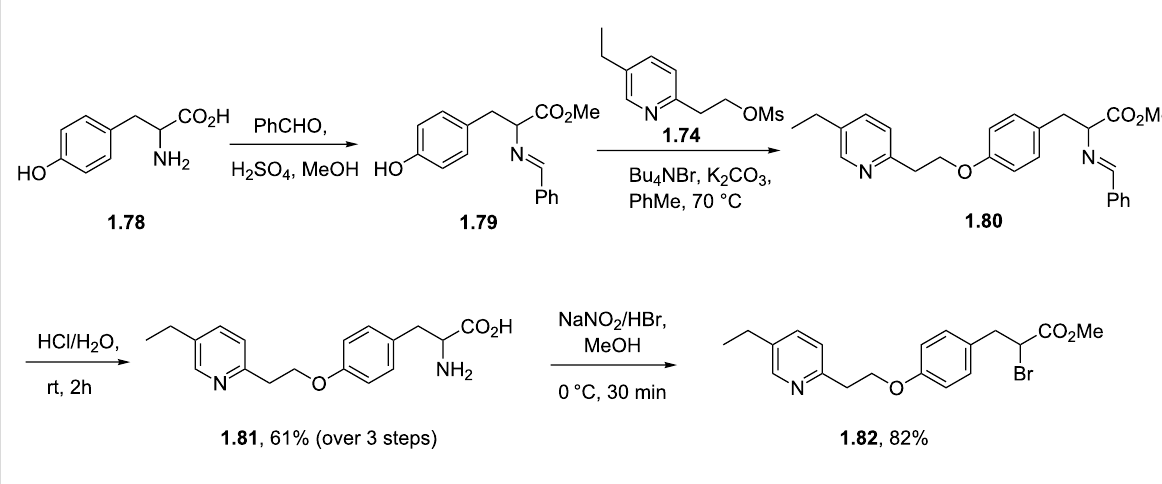
Scheme 14: Route towards pioglitazone utilising tyrosine.